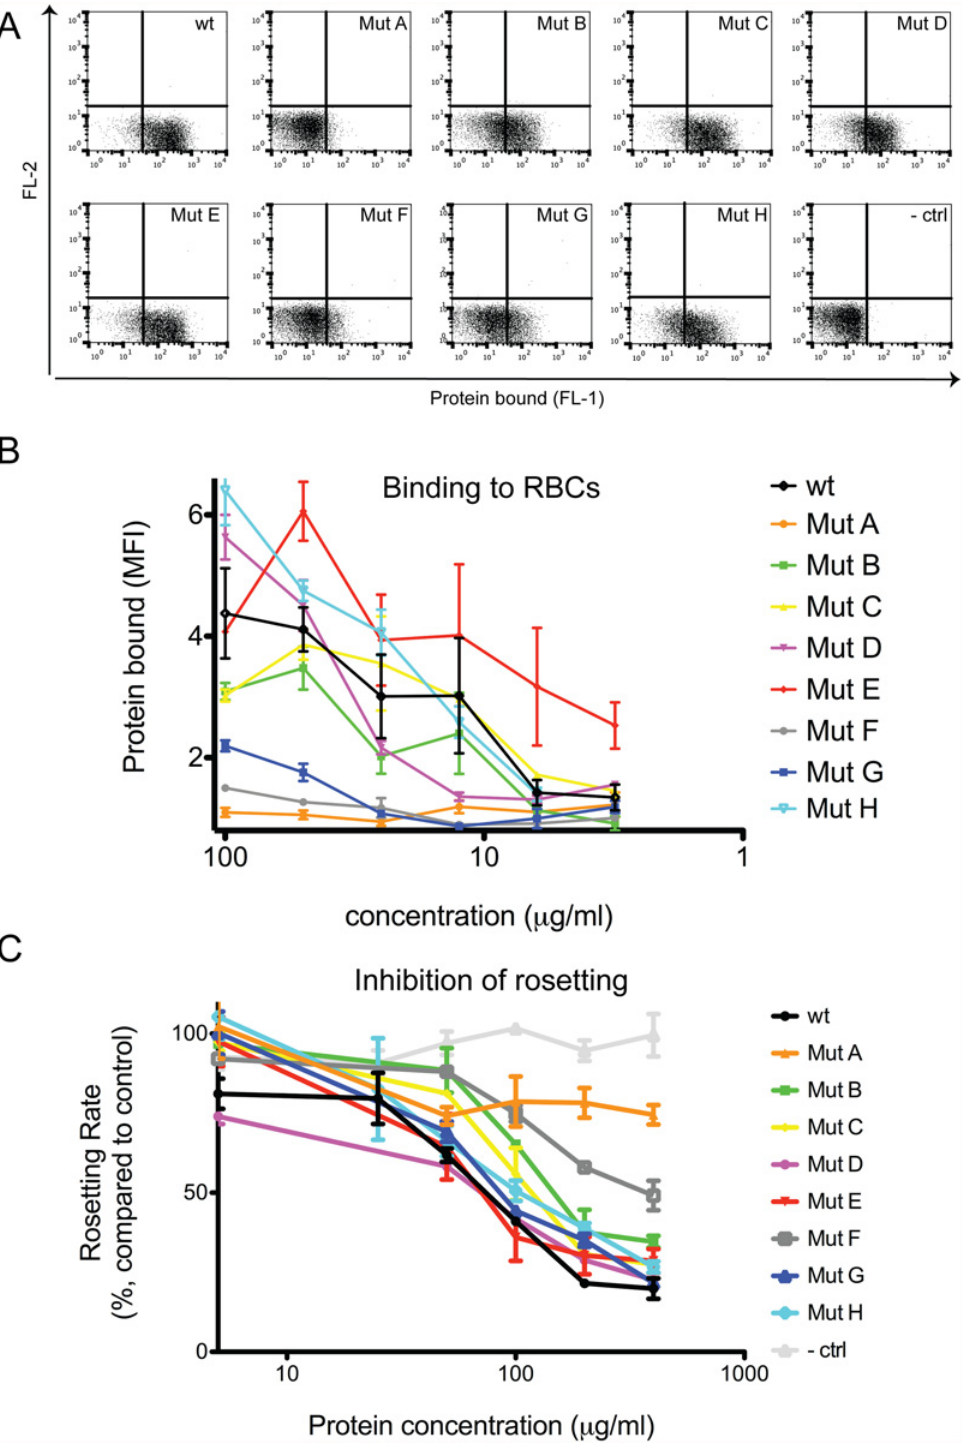
Fig 3. Functional activity of the mutated proteins. Mutant proteins were tested for their ability to bind O + RBCs and disrupt FCR3S1.2 rosettes. A) Representative dot plot of protein binding to RBC at the highest concentration (100 μ g/ml) from flow cytometric analysis. B) Proteins were tested in serial dilution from 100 μ g/ml to 3.06 μ g/ml for binding to RBCs. Results are presented as mean fluorescence intensity (MFI) fold increase over a negative control. Three independent duplicate experiments were performed. C) FCR3S1.2 trophozoite rosettes were mechanically disrupted and allowed to reform in presence of different concentration of mutant proteins. Proteins were tested at different concentration ranging from 400 μ g/ml to 5 μ g/ml. Three independent experiments were performed in duplicate, results shown are average ± SEM. doi:10.1371/journal.pone.0118898.g003 PLOS ONE | DOI:10.1371/journal.pone.0118898 March 5,